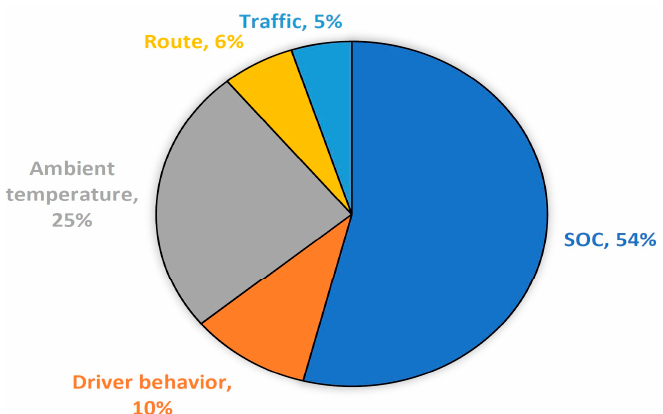
Figure 8. The importance of different parameters on EV range prediction (note that the values for ambient temperature consider using an HVAC system for air conditioning in summer or heating in winter).